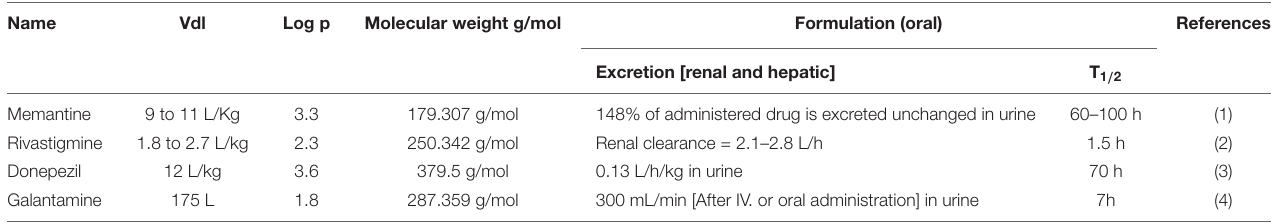
TABLE 2 | The pharmacokinetic profile of FDA-approved drugs for